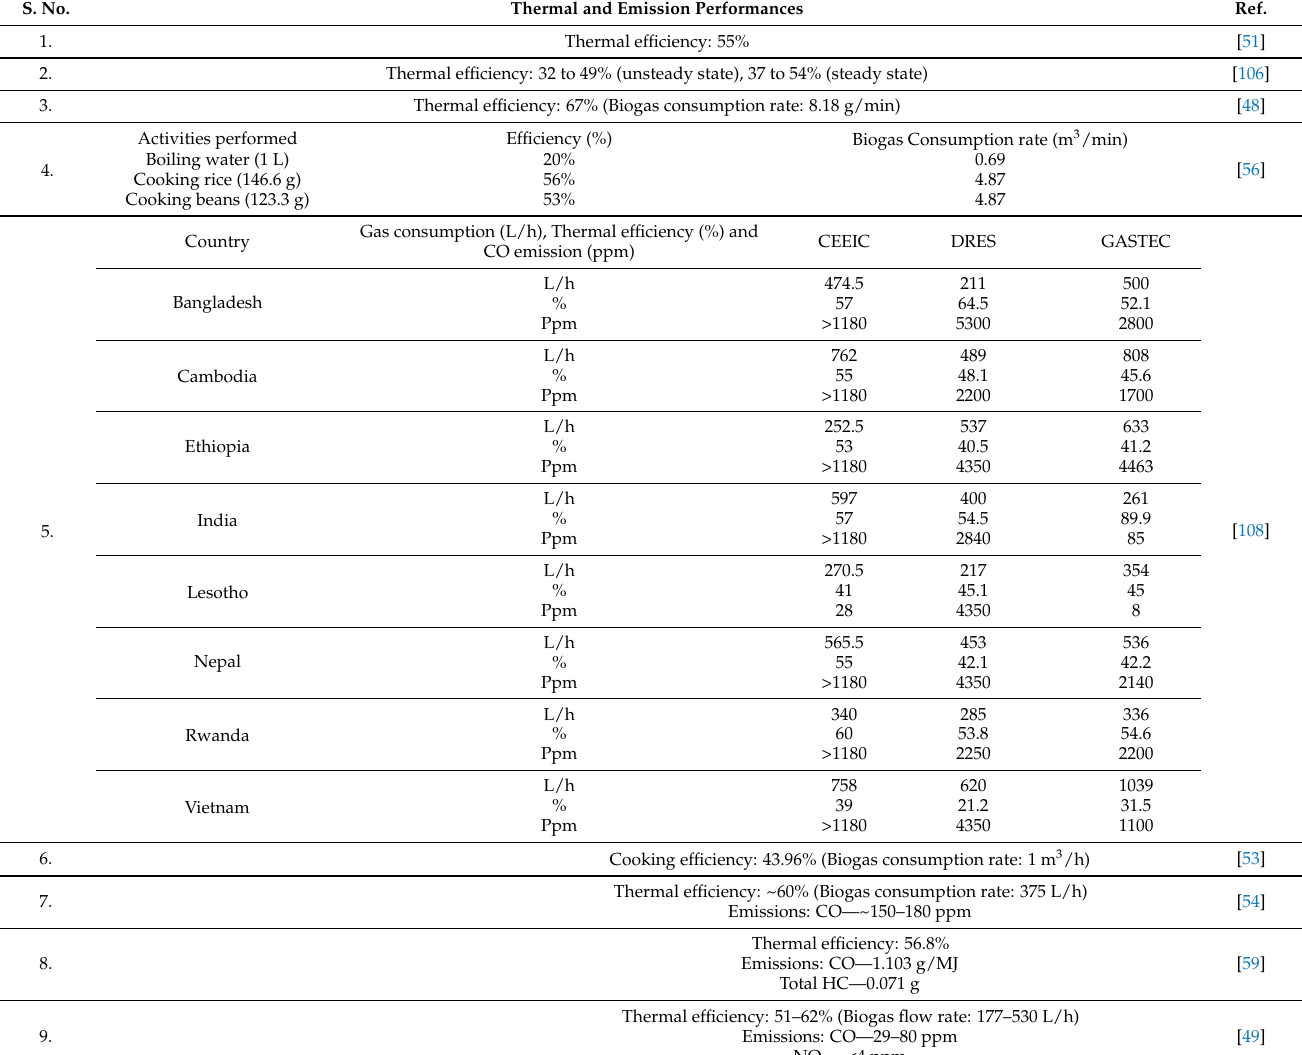
Table 5. Summary of literature on the performance tests of biogas cook-stove carried out in the